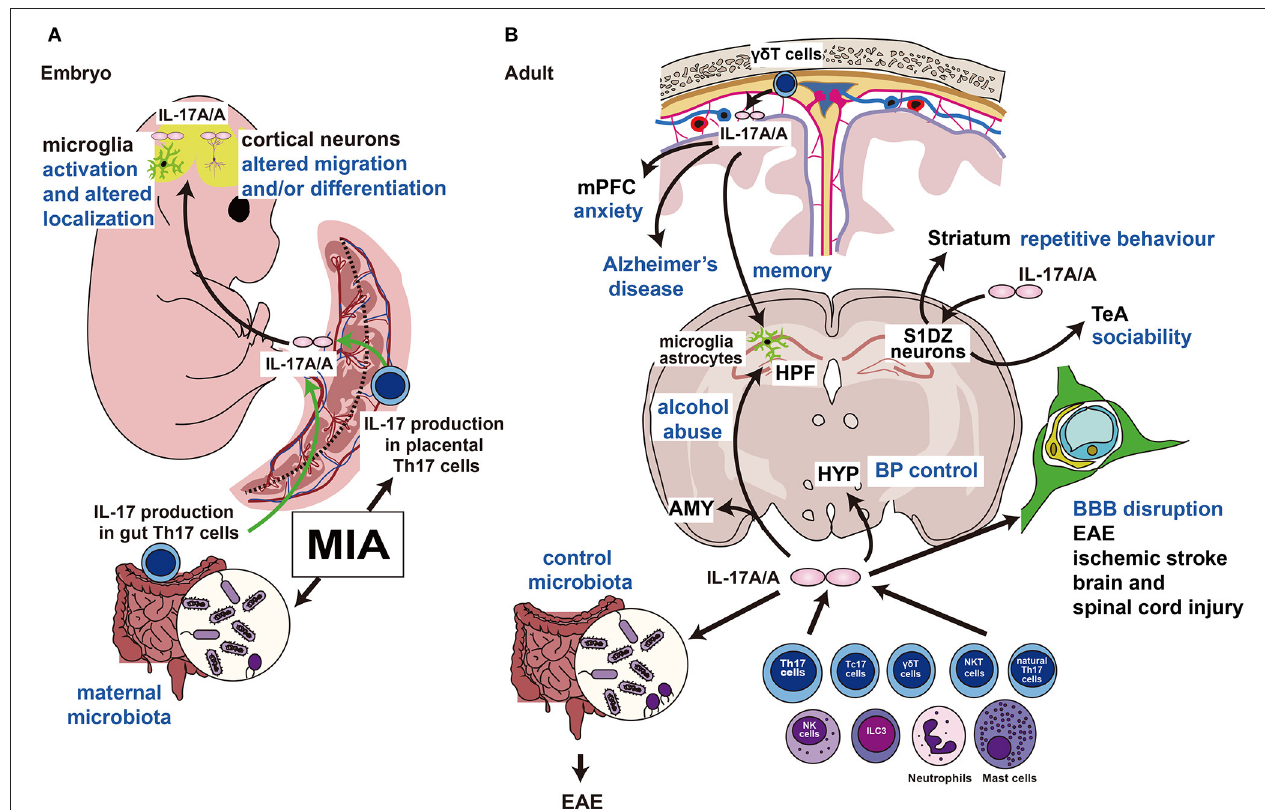
FIGURE 2 | Functions of IL-17A in the embryonic and adult brains. (A) MIA induces the production of IL-17A (IL-17A/A indicates the homodimer) in Th17 cells of the maternal intestine and placenta. IL-17A crosses the blood-placental barrier and affects embryonic brain development. (B) IL-17A is produced by γδ T cells in the cranial meninges and regulates the mPFC, which controls emotion, and HPF, which regulates memory formation. This pathway may be activated in the Alzheimer’s disease model. Direct injection of IL-17A into the S1DZ restores the ASD phenotypes of repetitive behavior or sociability. IL-17A also controls the gut microbiota, and its disruption causes autoimmunity. IL17A is involved in the destruction of the BBB in several neurological disorders. Intravenous injection of IL-17A affects the hypothalamus and alters systemic blood pressure. IL, interleukin; MIA, maternal immune activation; Th17, T helper 17; mPFC; medial prefrontal cortex; HPF, hippocampal formation; S1DZ, primary somatosensory cortex dysgranular zone; ASD, autism spectrum disorder; BBB, blood-brain barrier; HYP, hypothalamus; BP, blood pressure; EAE, experimental allergic encephalomyelitis; Tc17, IL-17-producing CD8 + T cells; NKT, natural killer T cells; NK; natural killer cells; ILC3, type 3 innate lymphoid cells; AMY, amygdala; TeA, temporal association